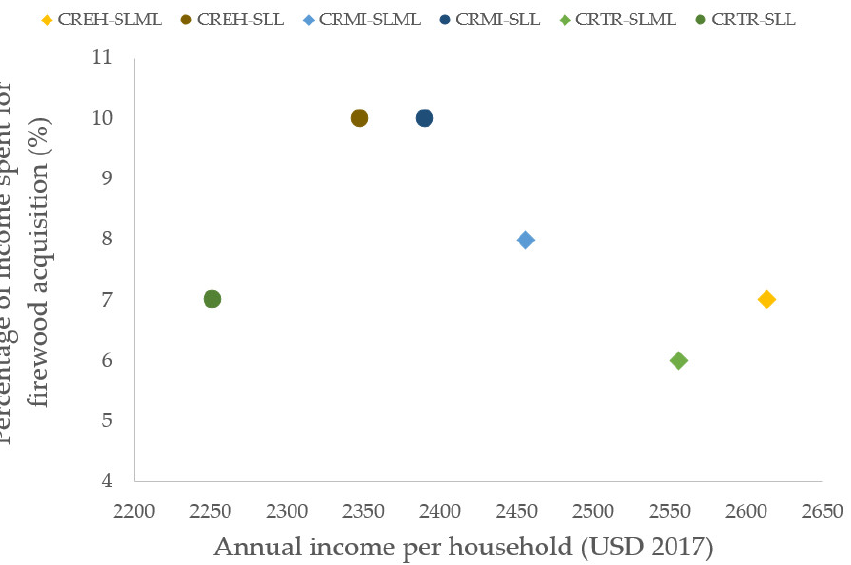
Figure 6. Percentage of household income spent by exclusive users of firewood on acquiring firewood, by climate region and socioeconomic level. EH, extreme heat; MI, mild; TR, tropical; ML, moderately low; L, low. Source: Own elaboration.